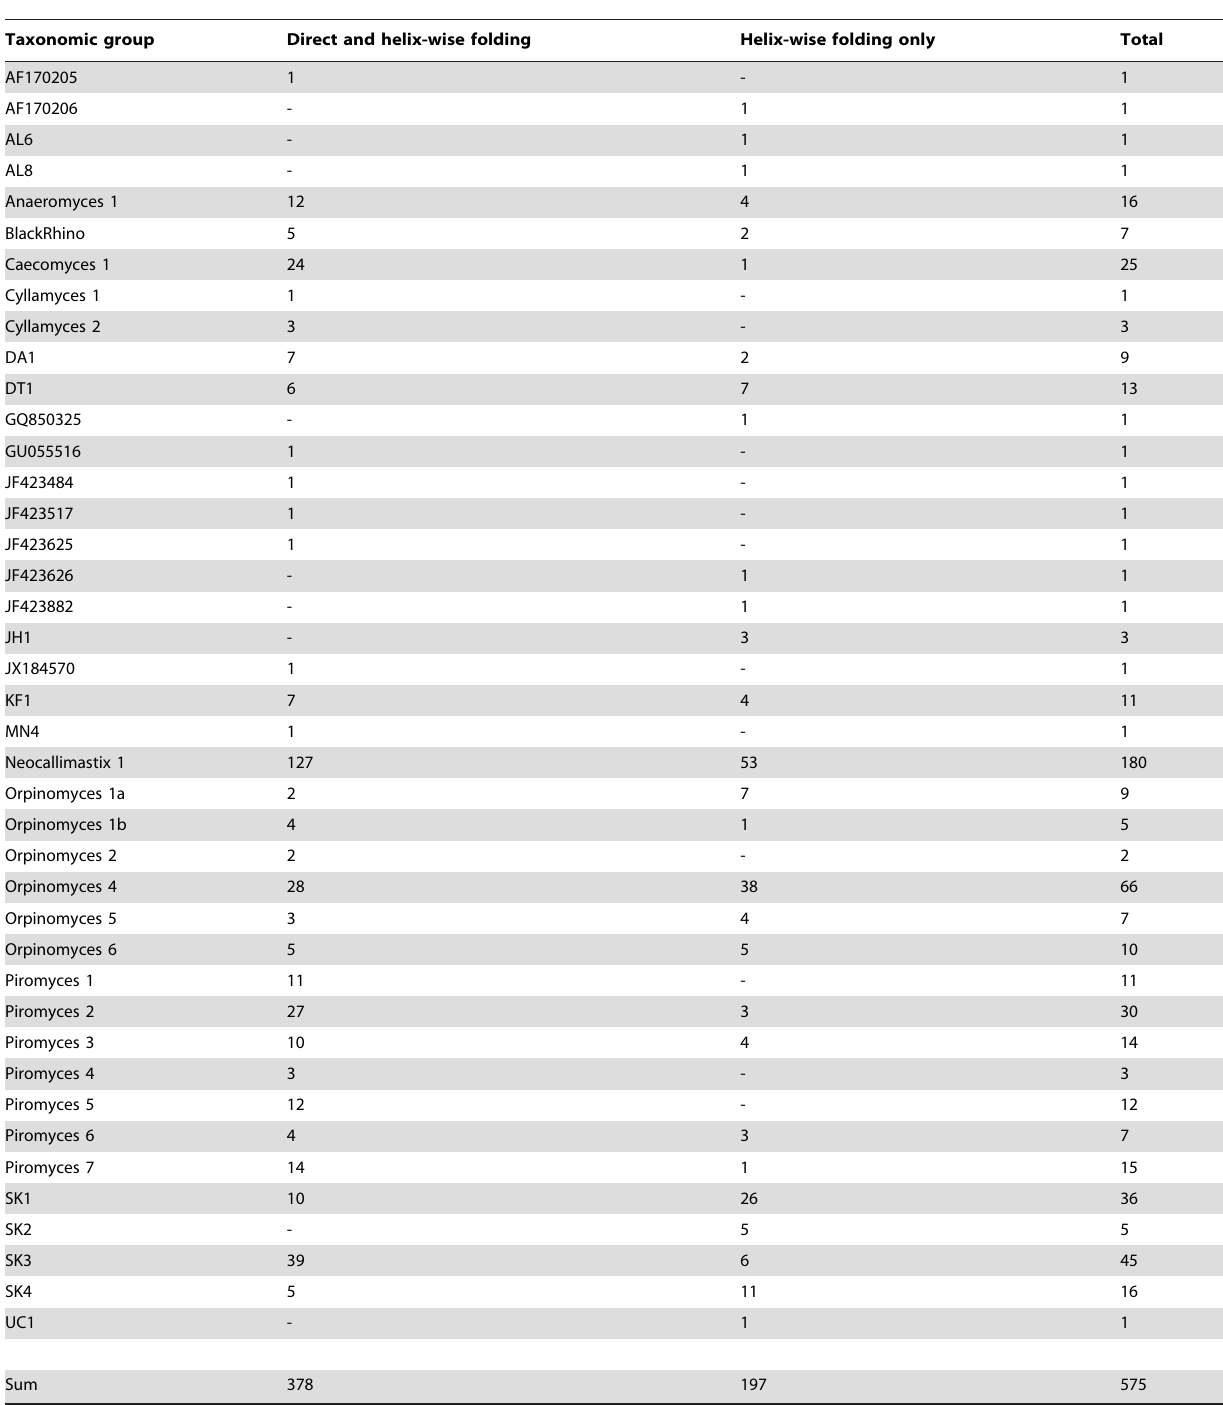
Sequences could either be folded into the three-helix core structure using both direct folding and helix-wise folding (direct and helix-wise folding) or only by helix-wise folding (helix-wise folding only). All 575 sequence-structure combinations were used for phylogenetic tree